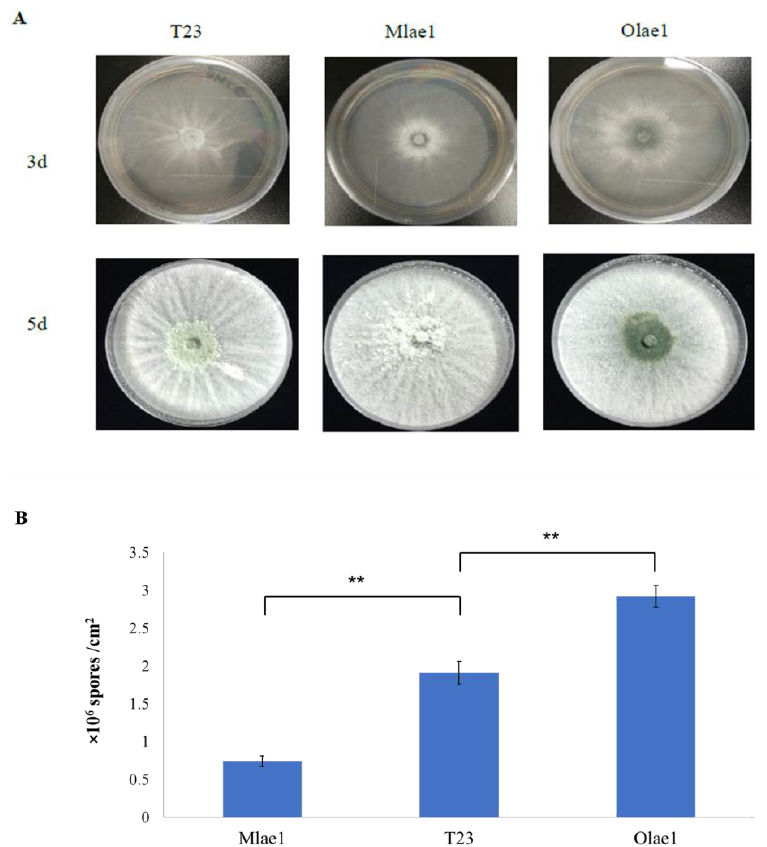
Figure 1. Growth phenotype of the three strains cultured on ( A ) PDA medium for 3d and 5d and ( B ) number of spores in the three strains (T23, Mlae1 and Olae1). Significance level determined using t -test; denoted by **: p <